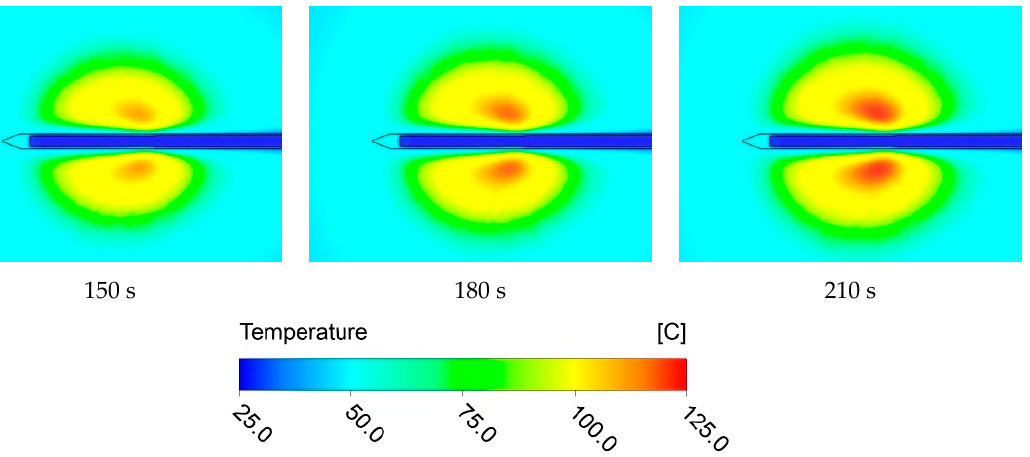
Figure 6. Temperature contour diagram in the liver tissue as a function of time. The results correspond to Case 5 for a 30 W input power and a coolant mass flow rate of 1 g/s.